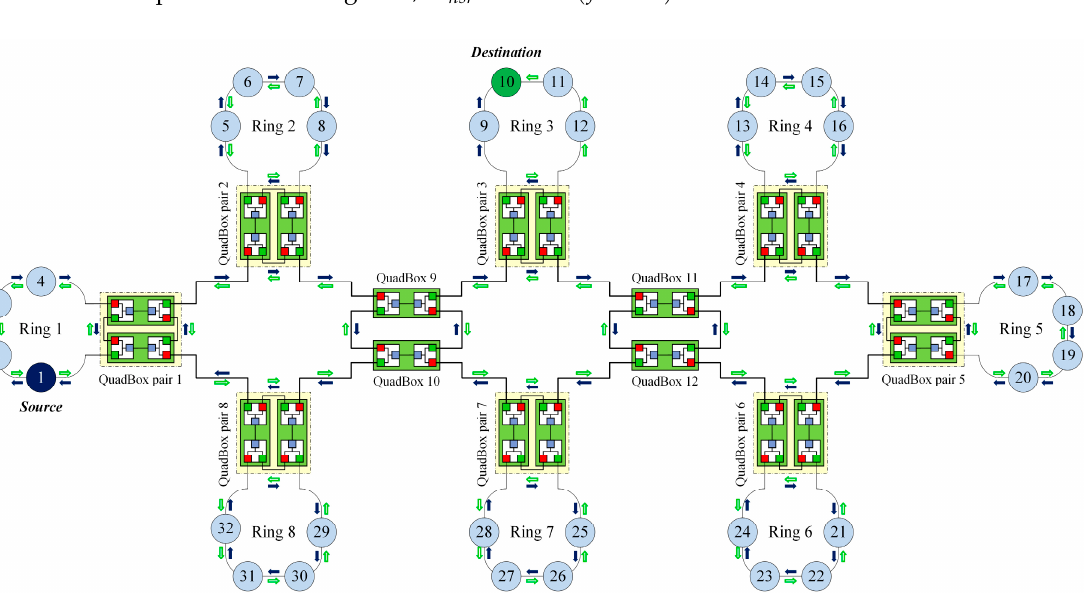
Figure 7. Network traffic under the standard HSR protocol.